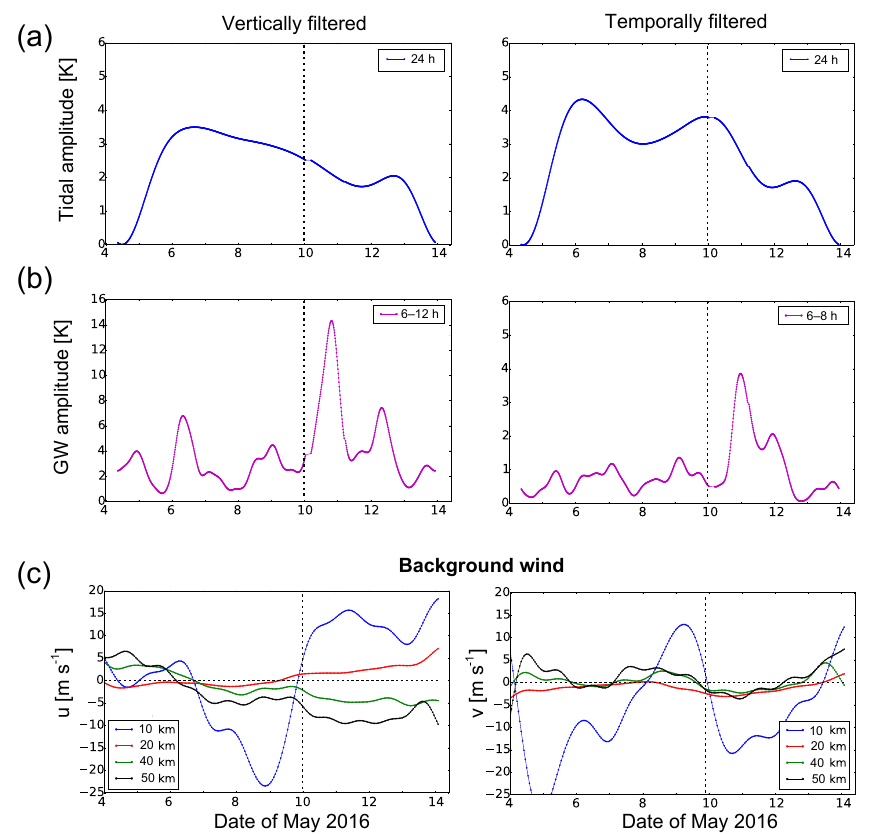
Figure 10. Wavelet amplitudes of (a) the diurnal component and (b) gravity waves at 45km altitude compared to (c) the zonal and meridional wind from ECMWF at different altitudes. The vertical dashed line indicates 00:00UT on 10